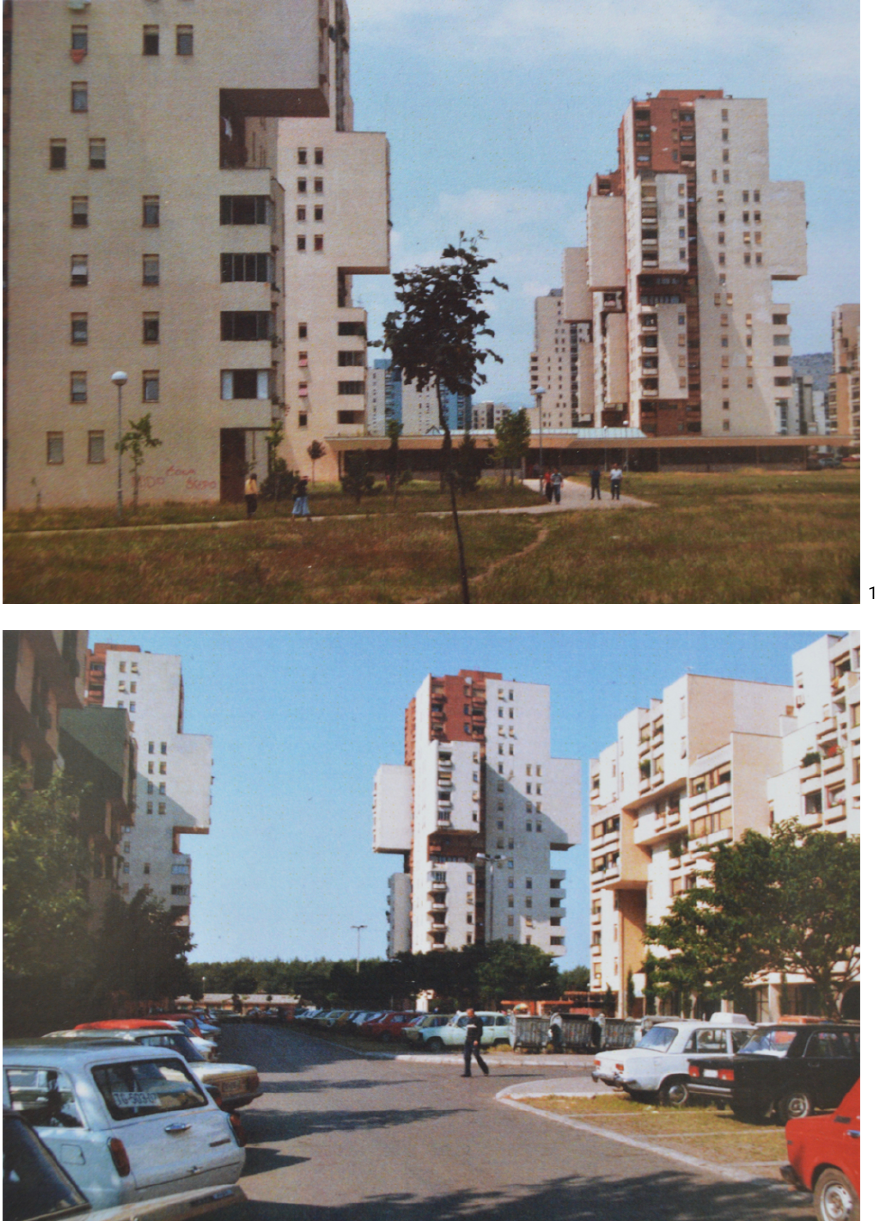
collection)Fig. 1 Blok 5, central area, undated. (Source: Mileta